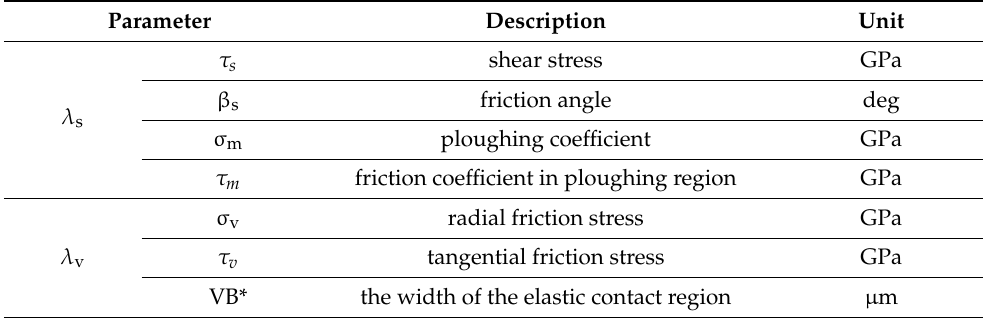
Table 1. The parameters of the nonlinear cutting force model for micro-milling.